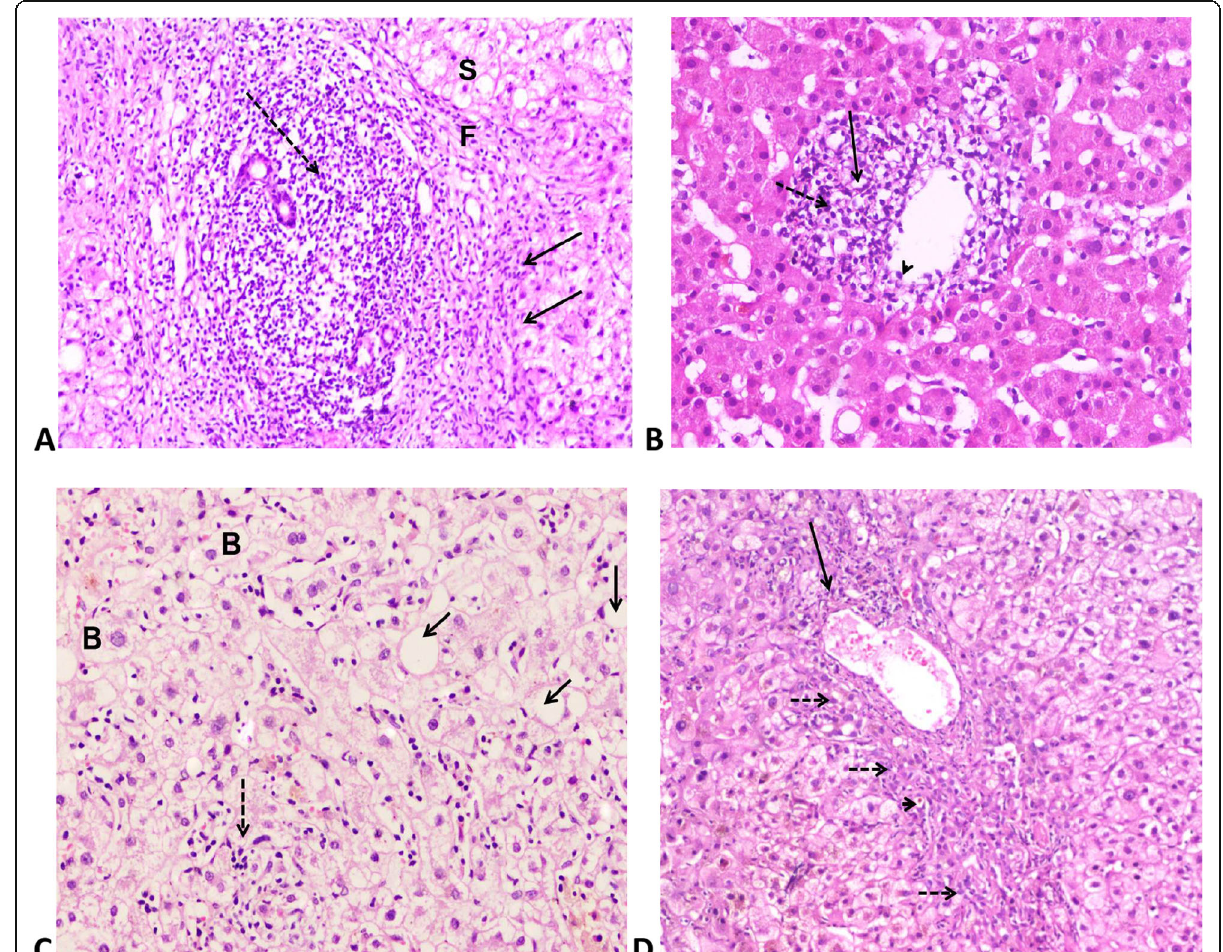
Fig. 1 Liver biopsy findings post liver transplantation: a Recurrent HCV infection showing portal tract mononuclear inflammatory infiltrate forming lymphoid aggregate (dashed arrow), interface hepatitis (arrow), fibrosis (F), and steatosis (S). b Acute cellular rejection demonstrating diagnostic portal tract triad of mixed cellular infiltrate (dashed arrow), bile duct injury (arrow), and venular endothelietis (arrow head). c Steatohepatitis exhibiting steatosis (arrows), ballooned hepatocytes (B), and neutrophilic rich infiltrate around hepatocytes (dashed arrow). d Biliary obstruction revealing mixed acute and chronic inflammatory cellular infiltrate (arrow), ductular proliferation (dashed arrow), and intraluminal bile plugs (arrow